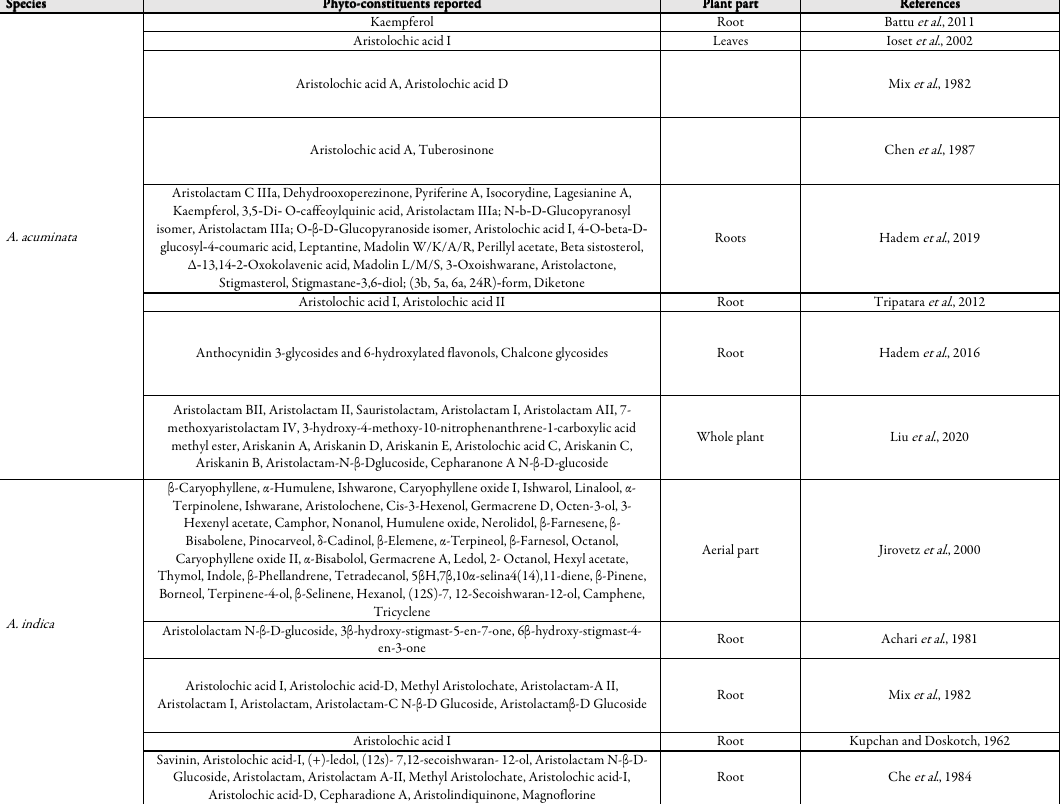
Table 2. Phyto-constituents of Aristolochia species distributed in Assam